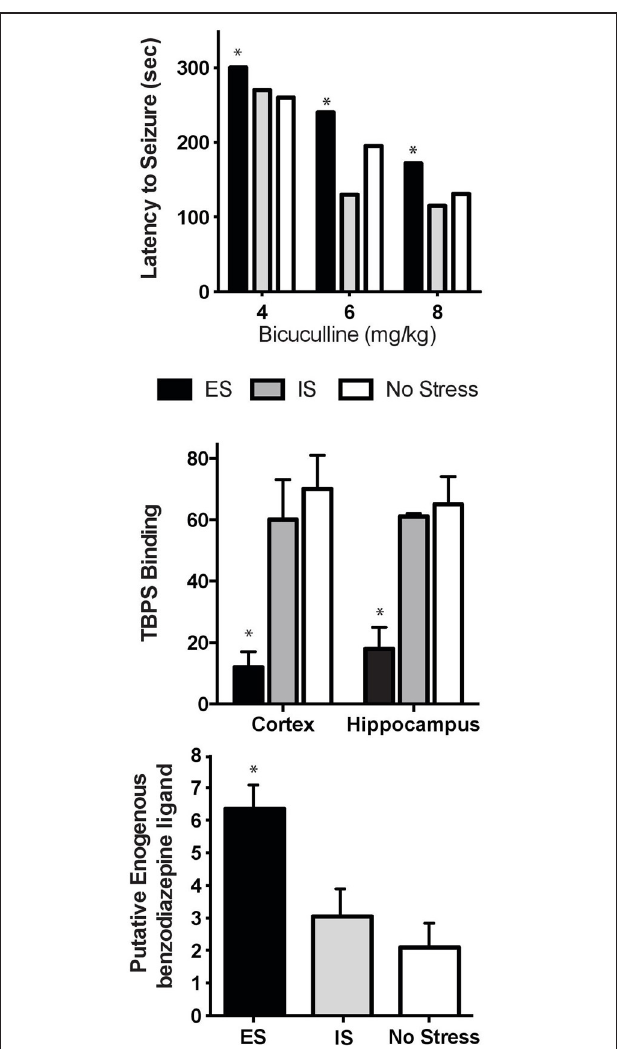
FIGURE 2 | Stressor Controllability and Central Benzodiazapine/ GABA A receptor. Top: Rats were exposed to ES, IS, or no stress, and then administered increasing doses of bicuculline 2h after stress. Rats with prior ES appeared to be protected from seizures with a significant delay in the onset of clonus seizure symptoms compared to unstressed rats [ES had a significantly longer latency compared to no stress controls ( ∗ p < 0 . 05). Adapted from Drugan et al., 1985c]. Middle: Mean ( + SEM) [ 35 S]TBPS receptor binding (2nM, fmol/mg protein brain tissue) 2h after stress. Exposure to ES significantly reduced competitive binding of the benzodiazepine receptor ligand ( ∗ p < 0 . 05, adapted from Drugan et al., 1994). Bottom: Mean ( + SEM) brain levels of benzodiazepine receptor agonist molecules (ng/mg brain tissue) 2h after stress. Prior ES significantly increased levels of endogenous benzodiazepine receptor ligands ( ∗ p < 0 . 05, adapted from Drugan et al.,